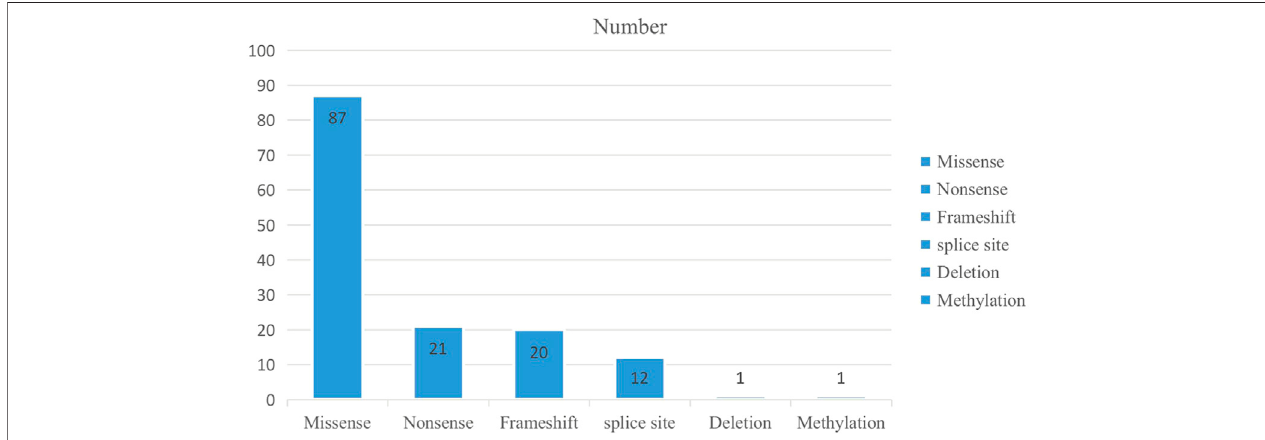
FIGURE 1 | The number of the variant type in 135 positive/likely positive